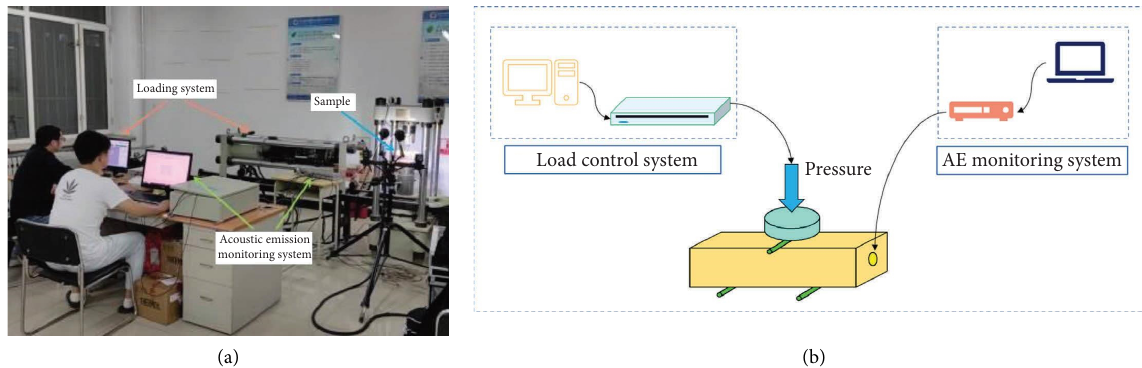
Figure 3: Experimental system: (a) physical diagram of the experimental system and (b) schematic diagram of the experimental